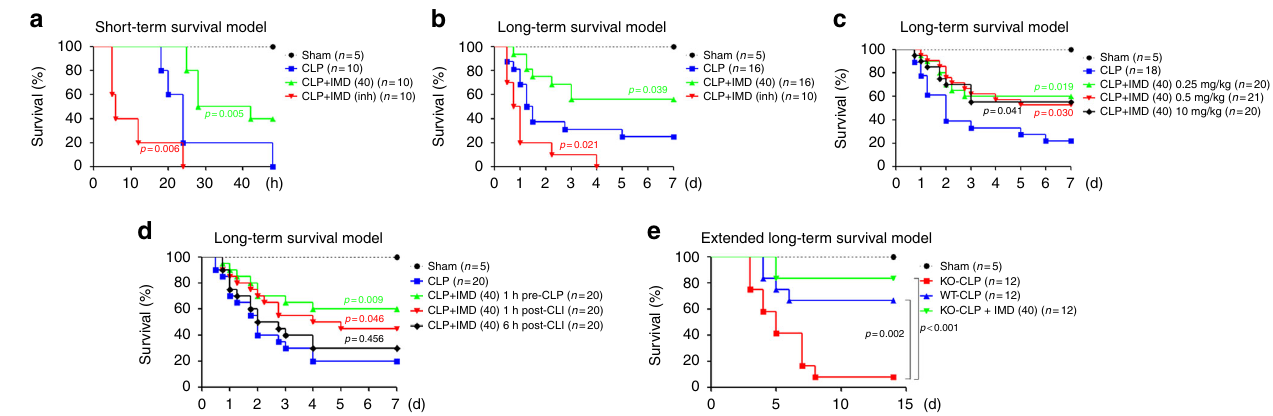
Fig. 7 IMD signi fi cantly improved the survival of septic mice. a – e Kaplan – Meier survival analysis of the septic mice. a , b The mice were treated with saline, IMD 40 (0.5 mg/kg) or IMD inh (1 mg/kg) 1 h before CLP surgery (short-term procedure, n = 10; or long-term procedure, n = 16) and every day for 3 days. c , d The mice ( n = 20) received long-term CLP procedure treated with IMD 40 at different dose ( c ) or timing ( d ). e The extended long-term CLP model using WT, IMD − / − mice, and IMD − / − mice ( n = 12) rescued by IMD 40 (subcutaneous injection, 0.25 mg/kg/day, 1 h before surgery and every day for 3 days). Each group was compared with the CLP-alone group, and signi fi cance was assessed by log